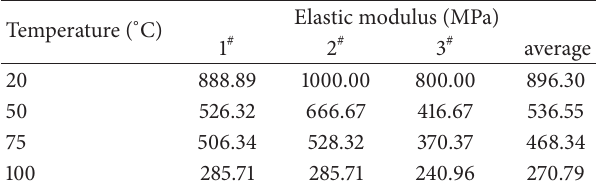
Table 2: Elastic moduli of lignite at different temperatures. Temperature ( ∘ C)